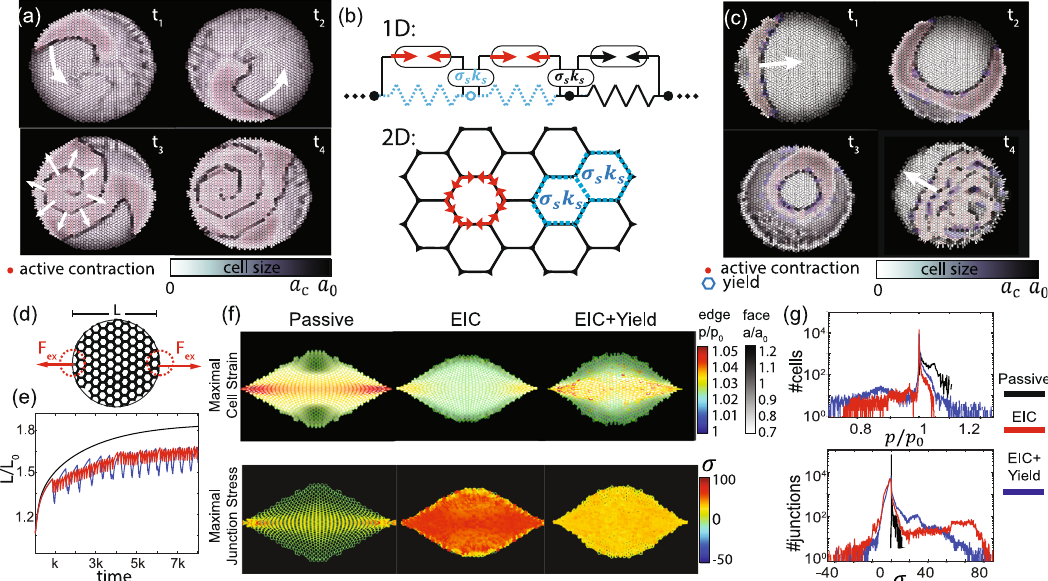
Fig. 4 2D tissue dynamics and the active cohesion hypothesis. a Sequential snapshots from a dynamic simulation of a 2D cellular sheet with EIC in an oscillatory mode (Supplementary Movie 3 left). Shown, is a case of area-trigger (where a cell ’ s critical area a c is lower than its rest-area a 0 ). Similar patterns appear with a perimeter-trigger (where a critical perimeter, p c , is lower than the rest-perimeter p 0 ). Greyscale represents cell area; red dots represent actively contracting cells. The white arrows highlight the propagation of circular and spiral pulses that have features similar to the 1D case: an extension front, followed by a shrinking front, while all cells in between are actively contracting. b Adding a yielding response to the model: when the tension on a cell – cell junction is higher than a critical value, σ s , an immediate softening occurs in both neighboring cells: a reduction in stiffness from k to k s (In the 2D case, the softening can be either in the perimeter stiffness k p or area stiffness k a ). In the sketch, arrows mark contractions, dashed blue lines mark softening. c Snapshots from a simulation of a tissue with both contraction and softening thresholds (Supplementary Movie 3 right). Red dots mark contracting cells, blue hexagons mark softened cells. The white arrows highlight the propagation of pulses with softening fronts accompanying the extension and shrinkage fronts. d – g Testing the response of an excitable tissue ( p c > p 0 ) to external stretch in the x -axis: d The pulling con fi guration: A constant force is pulling uniaxially on the sheet, acting directly on a fi xed set of cells on each side (marked with red dashed circles). e The distance between the pulling points L , normalized to the distance at rest L 0 , as a function of time. f We present peak values of mechanical fi elds per pixel across the tissue. We show the maximal cell perimeter strain ( p / p 0 ), area strain ( a / a 0 ) and junction stress ( σ ) throughout the simulation. We compare a passive material, a material with contraction response (EIC) and a material with both EIC and yielding responses. The contractile material dynamically distributes the strains in the tissue but presents high levels of junction stress. A material with the added yield-response increases slightly the levels of cell strain but cuts-off high junction stress values. See also Supplementary Movie 4 and Supplementary Fig. 3. g Histogram-view of all data points in the pulling